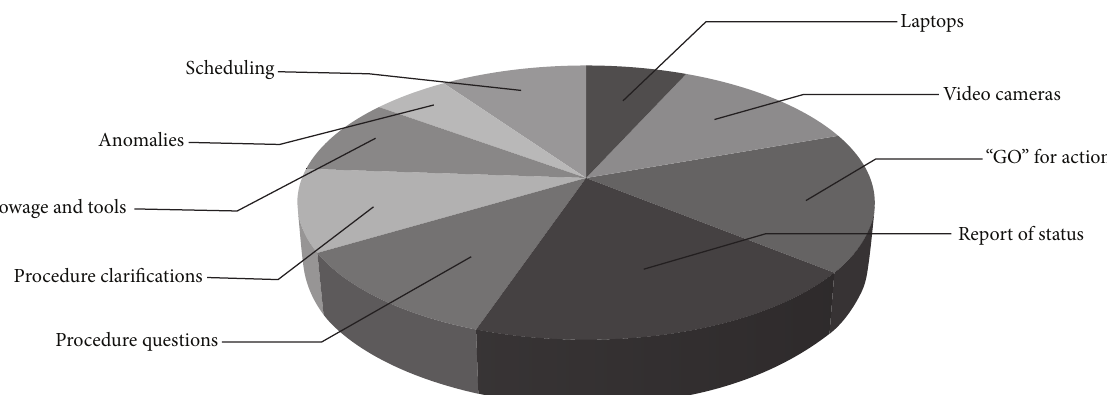
Figure 6: Subjects addressed during crew calls ( 𝑁 = 134 ).